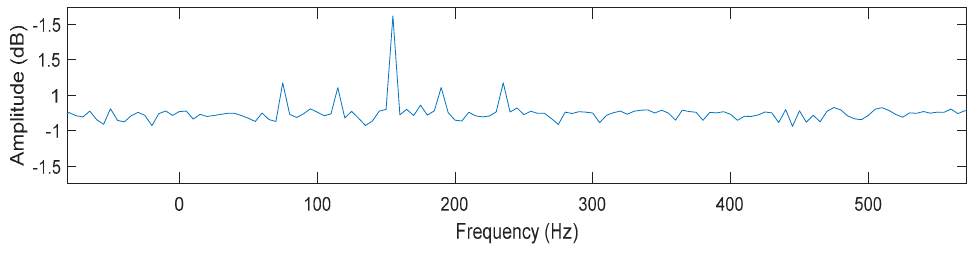
Figure 10. Segmented